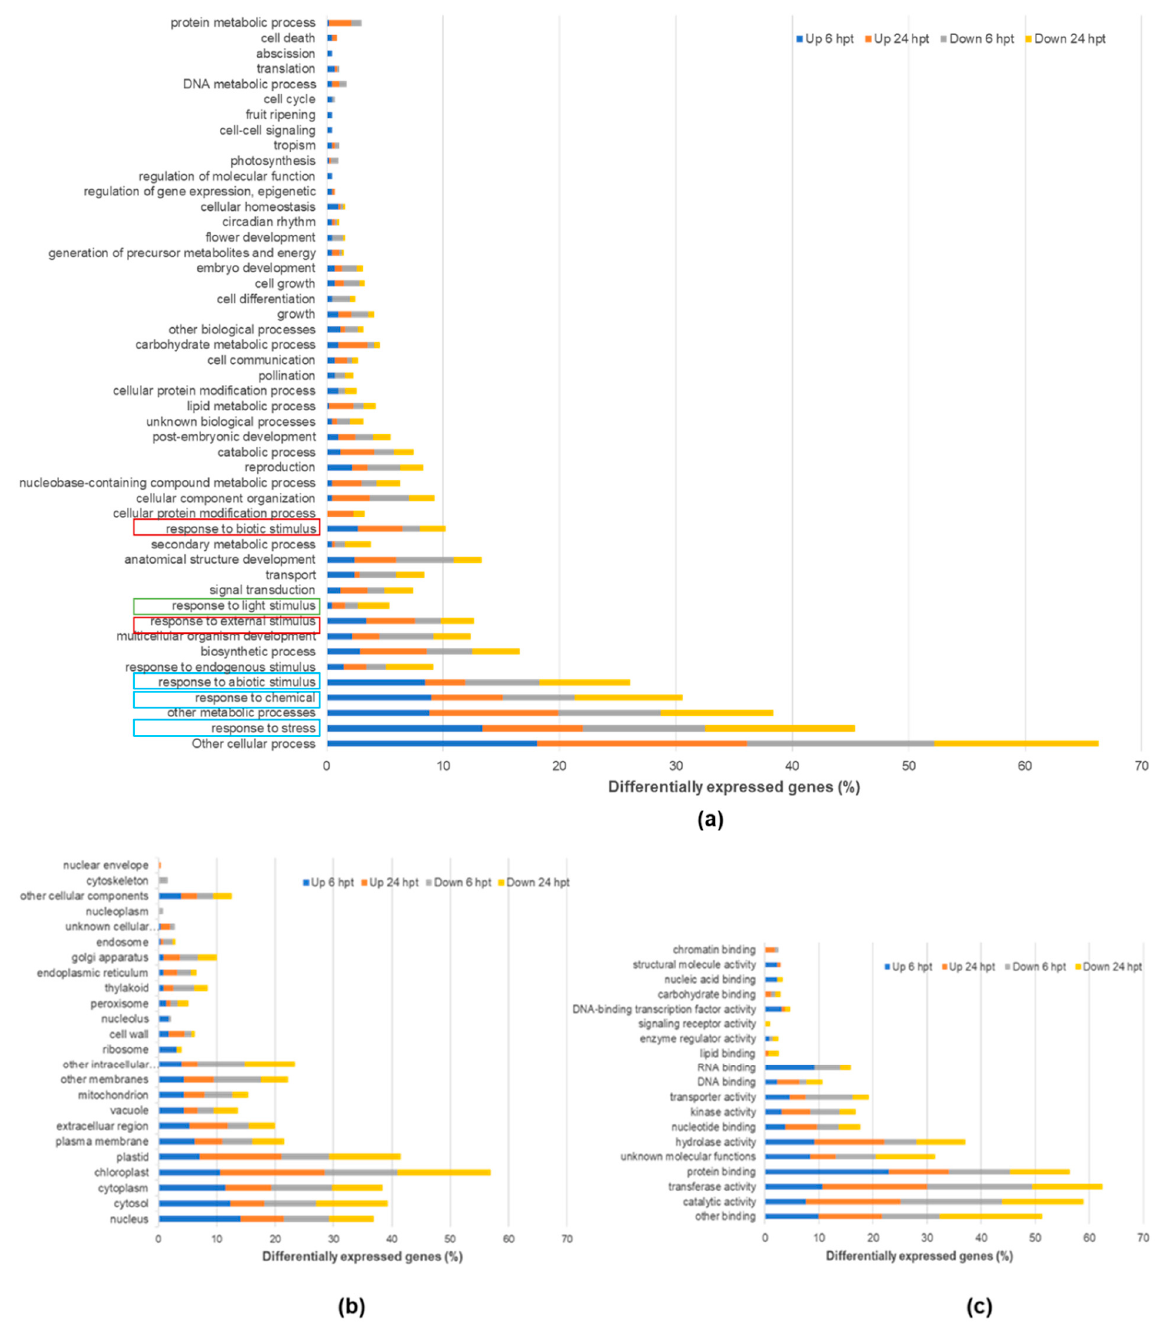
Figure 3. Percentage of differentially expressed genes (DEGs) by SSG for BP ( a ), CC ( b ), and MF terms ( c ) at 6 and 24 hpt. The expressed genes were determined with EdgeR analysis and separated by their regulation type, down or up. GO terms and functional categorization of the genes are generated through TAIR (The Arabidopsis Information Resource). The GO term of interest in the same box of color depicts a similar pattern. Schemes follow the same formatting.